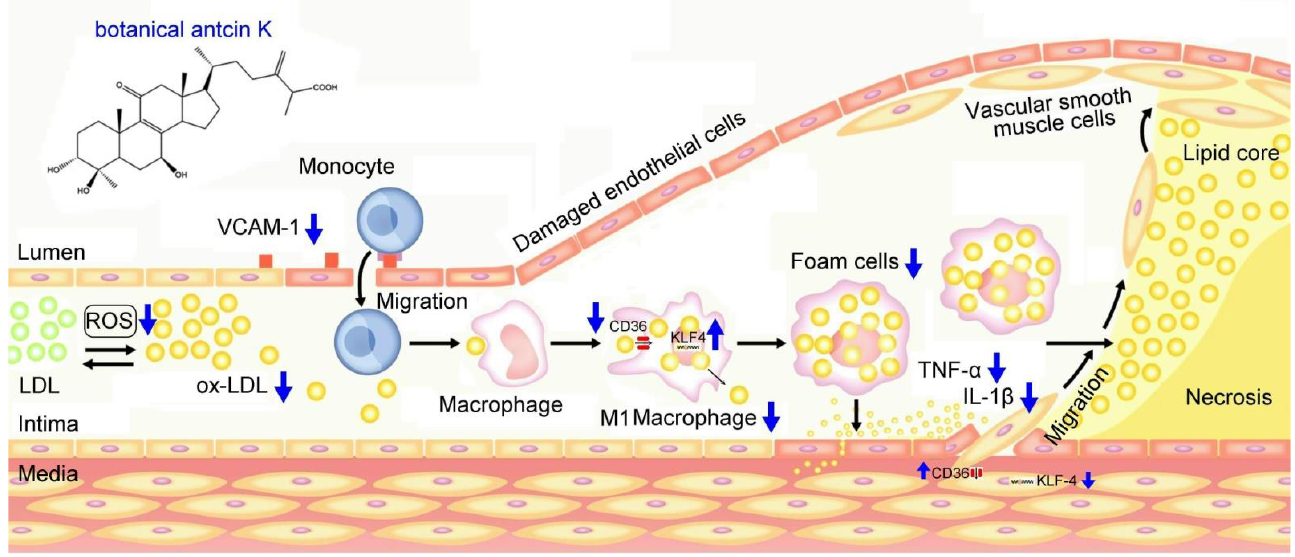
Figure 11. Possible therapeutic mechanisms of antcin K in alleviating the high-fat damage of vascular endothelial cells and macrophages in blood vessels. Antcin K treatment can (1) decrease the expression of VCAM-1 that alleviates circulating monocytes adhering to endothelial cells and migrating into subendothelial space; (2) reduce ROS generation and oxidative stress that alleviate the oxidative modification of lipoproteins and phospholipids; (3) enhance the expression of KLF4 in macrophages and endothelial cells that decrease lipid deposition and prevent macrophages converting into foam cells; (4) decrease the content of TNF- α and IL - 1β; and (4) decrease the expression of CD36 that slows transformation of macrophages and endothelial cells to foam cells.